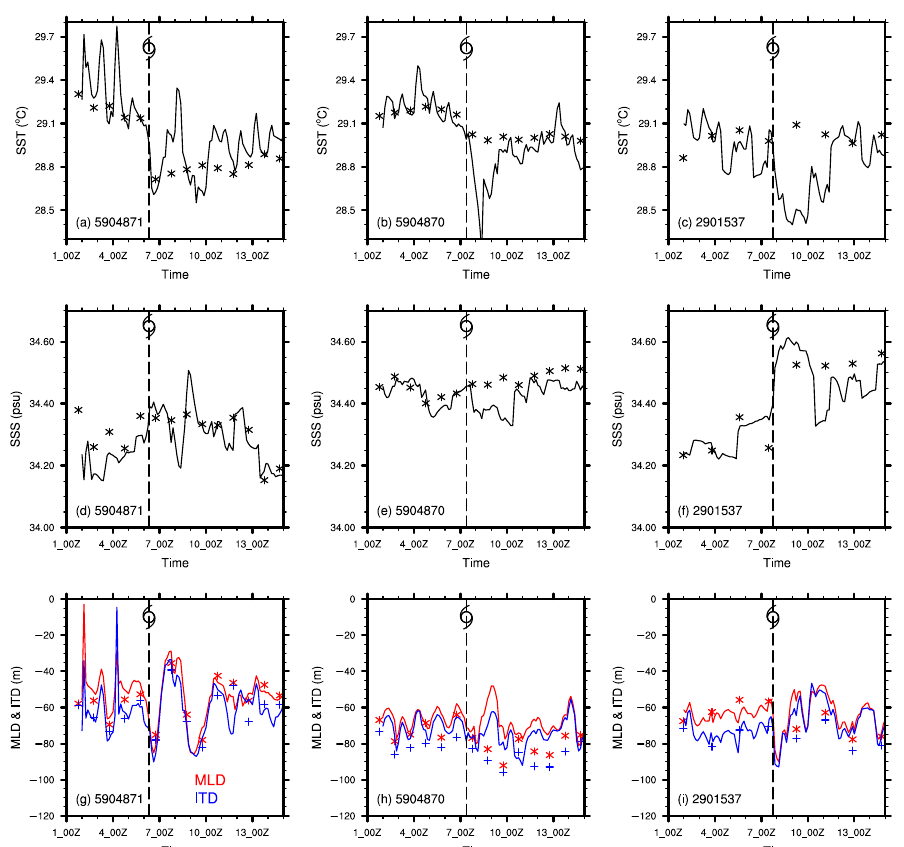
Figure 10. Time series of sea surface temperature (SST; ( a – c )), sea surface salinity (SSS; ( d – f )), mixed- layer depth (MLD; ( g – i )), and isothermal depth (ITD; ( g – i )) in Argo record during super-typhoon Haiyan. Left panels ( a , d , g ) Argo float 5904871. Middle panels ( b , e , h ) Argo float 5904870. Right panels ( c , f , i ) Argo float 2901537. The markers are from Argo in-situ observation, and the solid lines represent HYCOM results. In ( g – i ), the red asterisks and blue pluses are the MLDs and ITDs in Argo floats,